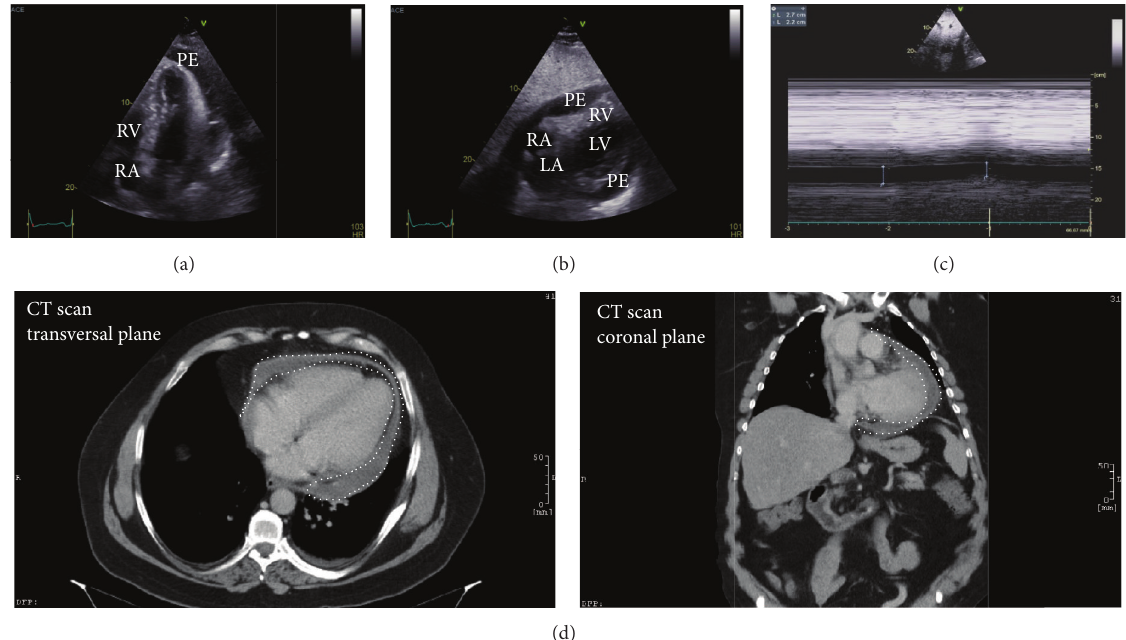
Figure 2: TTE demonstrating intermediate pericardial effusion leading to pericardial tamponade. (a) Apical four-chamber view showing intrapericardial pressure exceeding RA systolic pressure as evidenced by systolic RA collapse. (b) Subcostal view demonstrating diastolic RV collapse. (c) M-mode echocardiography of dilated inferior vena cava (27 mm) with < 50% inspiratory reduction. (d) CT with contrast agent reveals residual circumferential pericardial effusion after pericardiocentesis. Pericardial effusion is highlighted by a dotted white line. Structures: pericardial effusion (PE), right atrium (RA), right ventricle (RV), left atrium (LA), and left ventricle